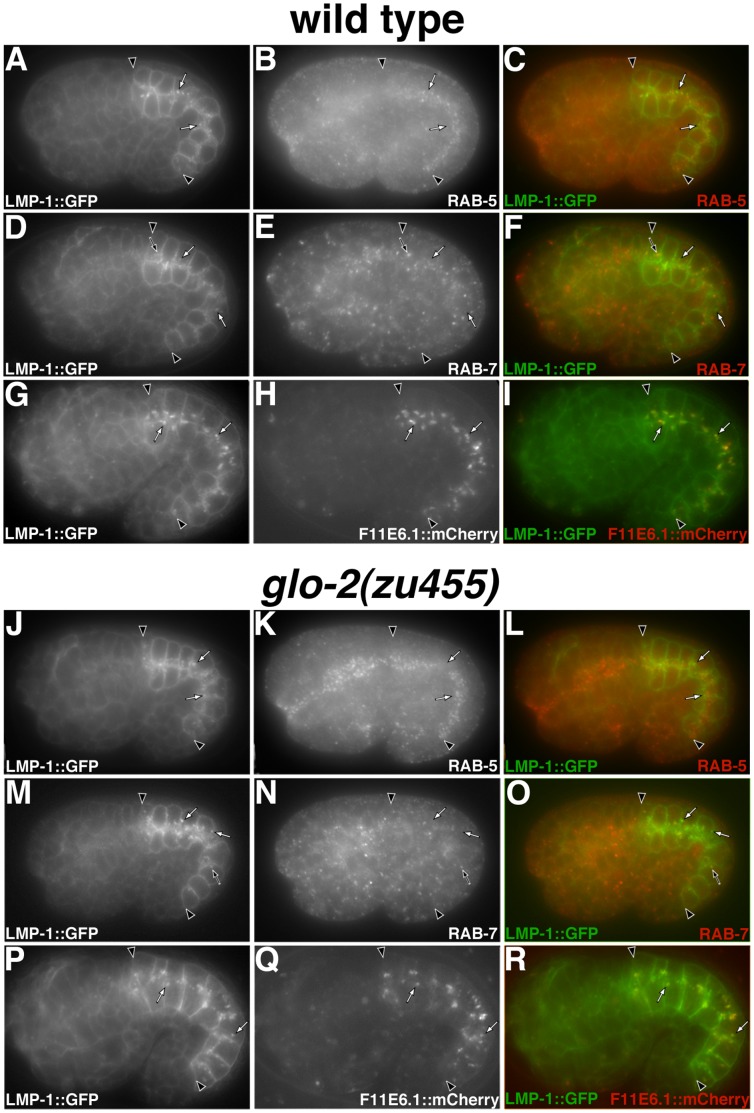
Analyzing the identity of LMP-1::GFP compartments in glo-2(
−)
 embryos. The majority of LMP-1::GFP containing compartments (marked with white arrows in all panels) lacked RAB-5 and RAB-7 in wild type (A–F) and glo-2(zu455) (J–O), however a subset of LMP-1::GFP colocalized with RAB-7 (black arrows). In both wild type (G–I) and glo-2(zu455) (P-R), the lysosomal hydrolase F11E6.1::mCherry localized to LMP-1::GFP containing organelles. In all panels, black arrowheads flank the intestine of 1.5-fold stage embryos.